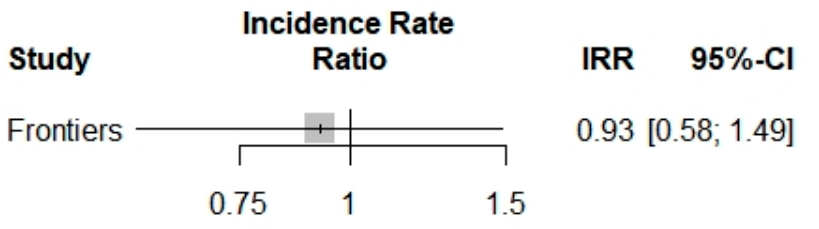
Figure 3. Incidence Rate Ratio of COVID-19 into beta-thalassemia carriers.